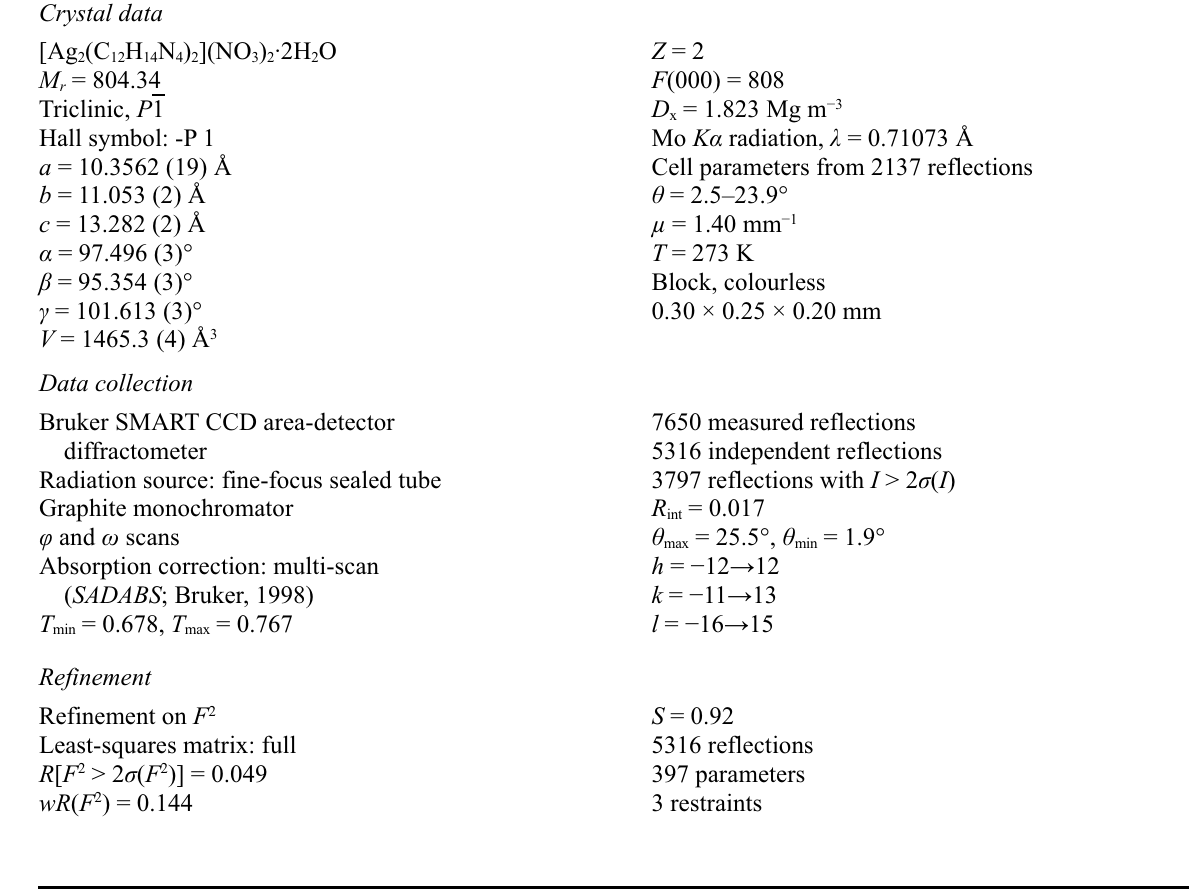
Figure 2 Partial packing view of [Ag involved in hydrogen bondings have been omitted for clarity.[Symmetry codes: (i) 1 + x , y , 1 + z ; (ii) x , y - 1, 1 + z ] Bis[ µ -1,4-bis(4,5-dihydro-1 H -imidazol-2-yl)benzene- κ 2 N 3 : N 3 ′ ]silver(I) dinitrate